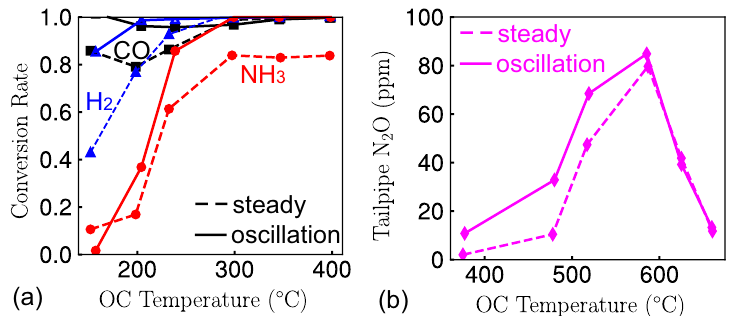
Figure 18. ( a ) Conversion rates of H 2 , CO and NH 3 in the oxidation catalyst; ( b ) concentration of N 2 O downstream the TWC during steady and dithering